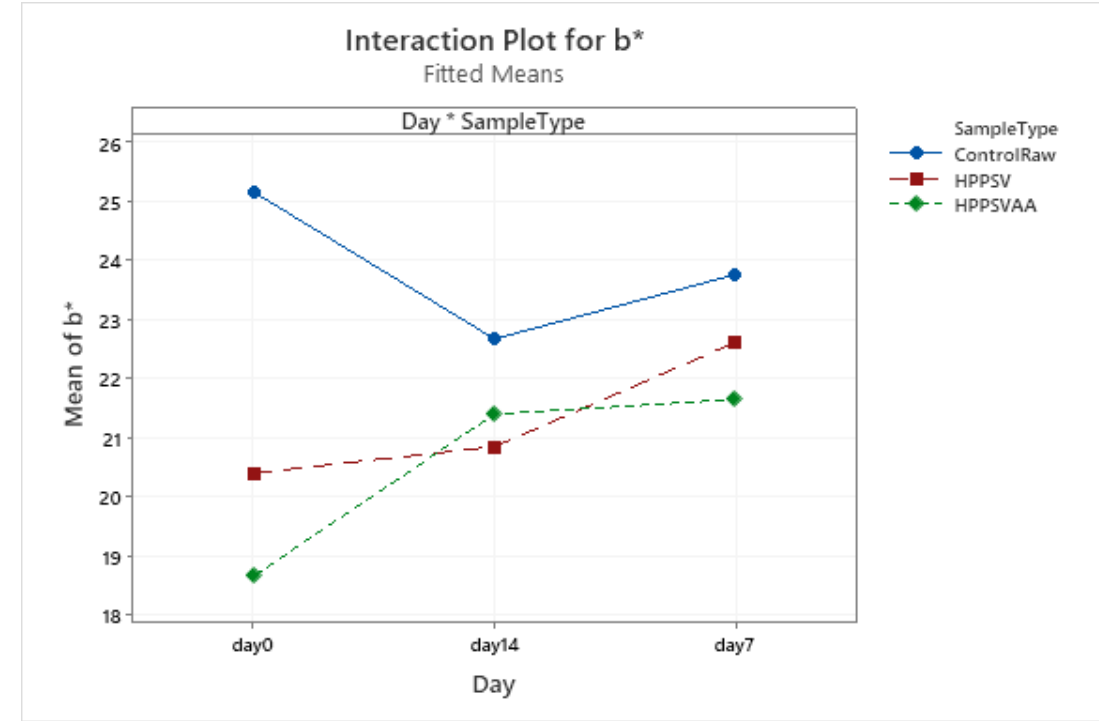
Figure A15. Effect of treatments and storage time on the b * coordinate of veal patty (HPPSV: HPP- SVCOOK).